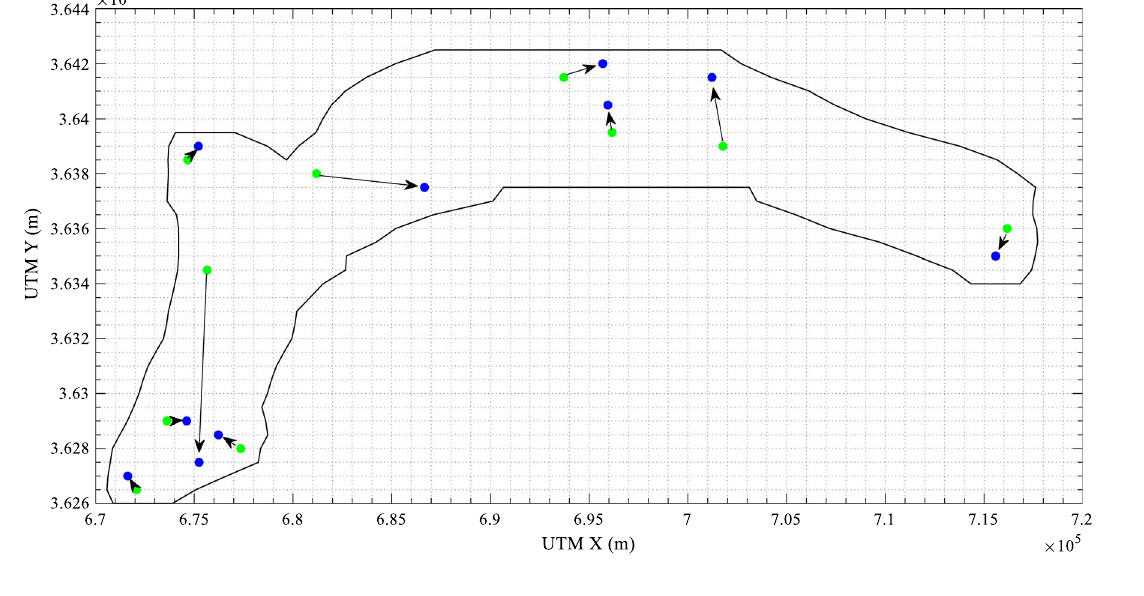
Fig. 6 The optimal location of observation wells Table 4 Optimal coordinates of observation wells in Birjand